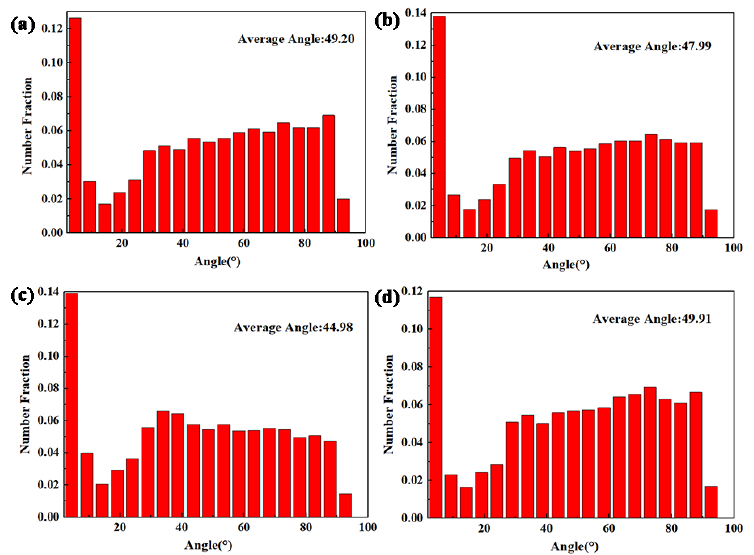
Figure 14. Mean MA value of the compressed Mg-13Gd-4Y-2Zn-0.4Zr (wt. %) samples: ( a ) initial samples; ( b ) L-653 sample; ( c ) L-743 sample; ( d ) H-743 sample.